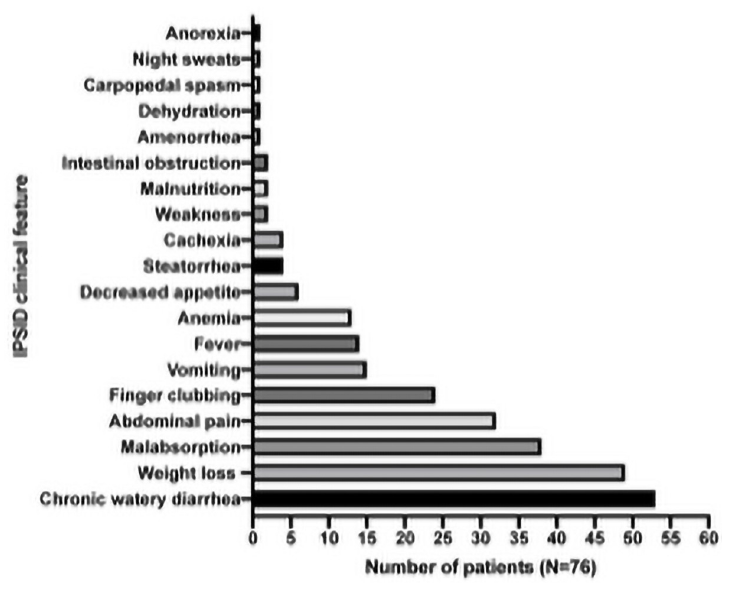
Fig 2. Frequency of the main clinical features